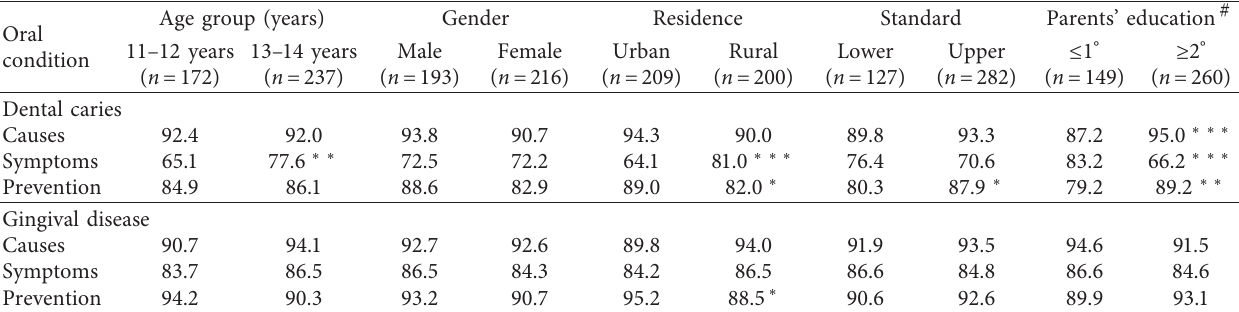
Table 3: Distribution of study participants in relation to knowledge about causes, symptoms, and prevention of dental caries and gingival disease by sociodemographic characteristics in percentages.